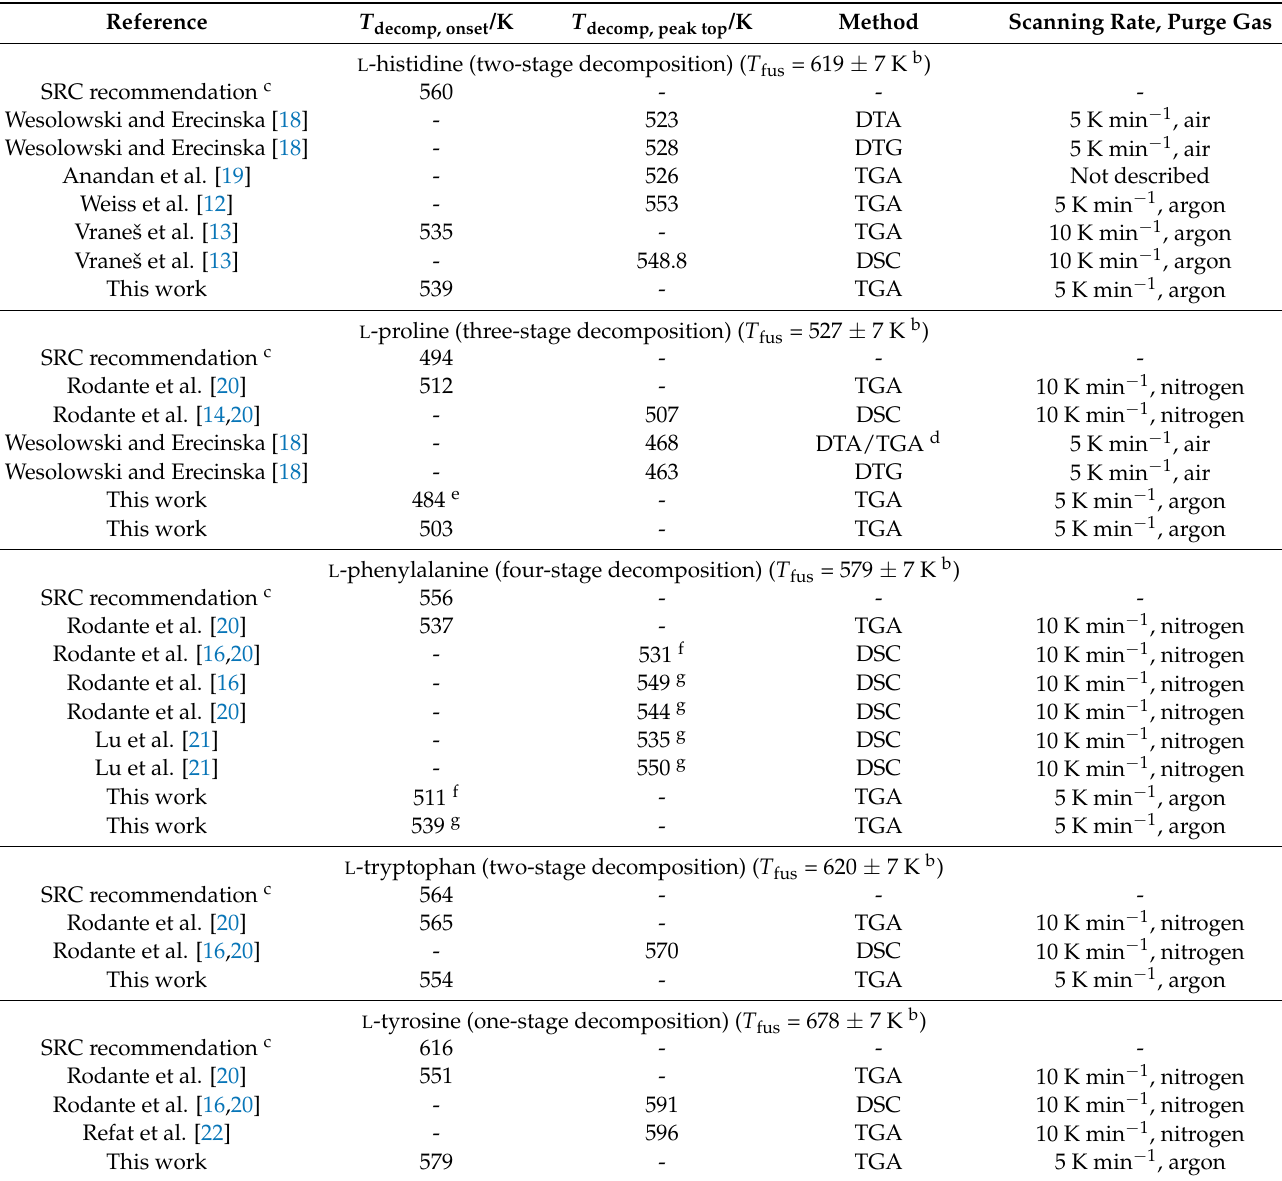
Table 1. Temperatures of fusion and decomposition of L -histidine, L -phenylalanine, L -proline, L -tryptophan, and L -tyrosine a . Reference T decomp, onset